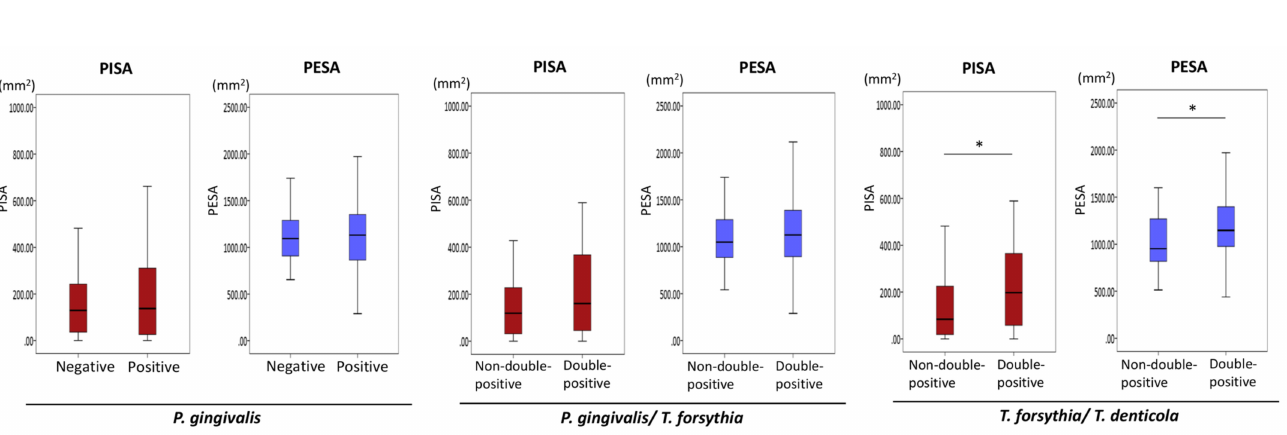
Figure 5. Associations of periodontopathic bacteria with PISA and PESA in propensity score-matched patients. Mann– Whitney U test. Statistical significance levels of p < 0.05 are indicated by